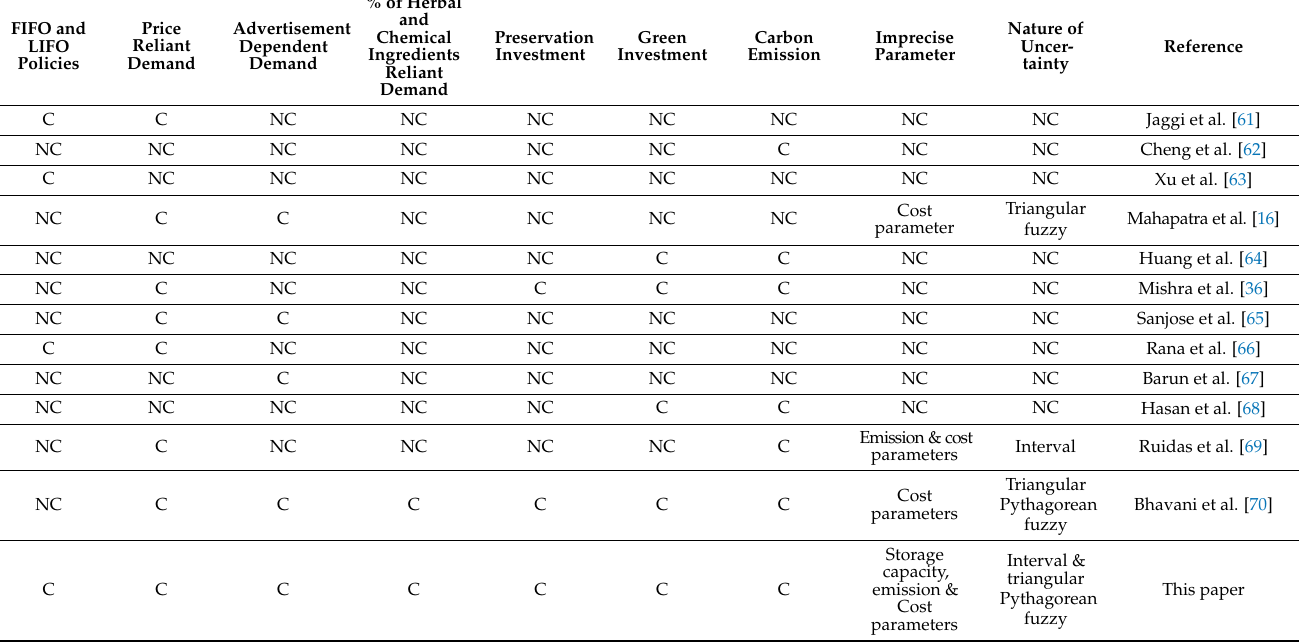
Table 1. Contribution of this work compared to previous analogous